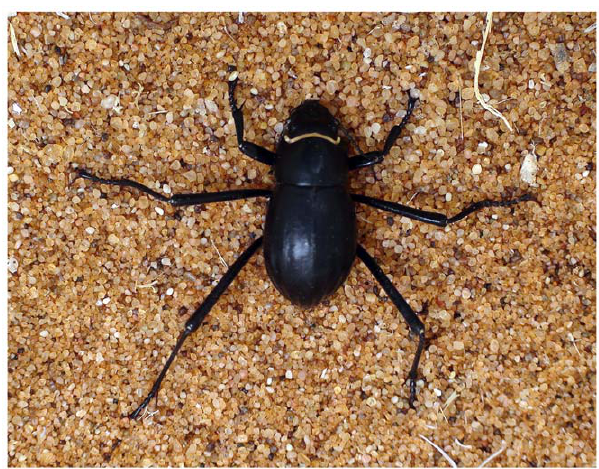
Figure 1. Fog basking beetle. The Namib Desert fog basking beetle Onymacris unguicularis (beetle length ca. 2 cm).